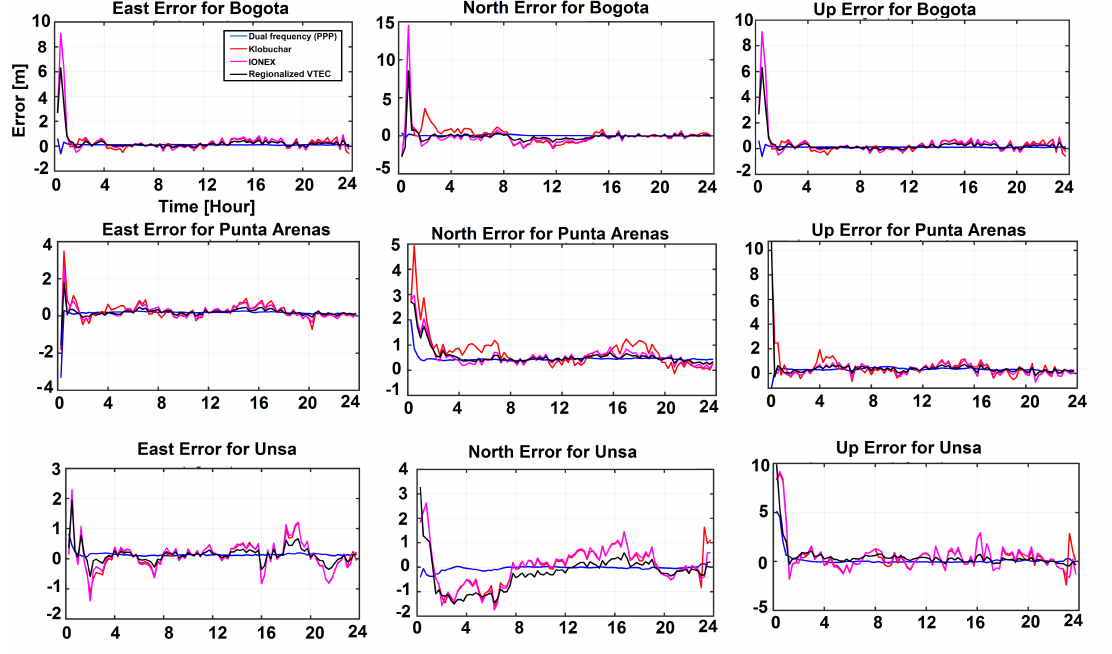
Figure 10. Position errors in the local east, north and height direction Bogota, Punta Arenas and Unsa stations on 21 December 2013 (DOY =